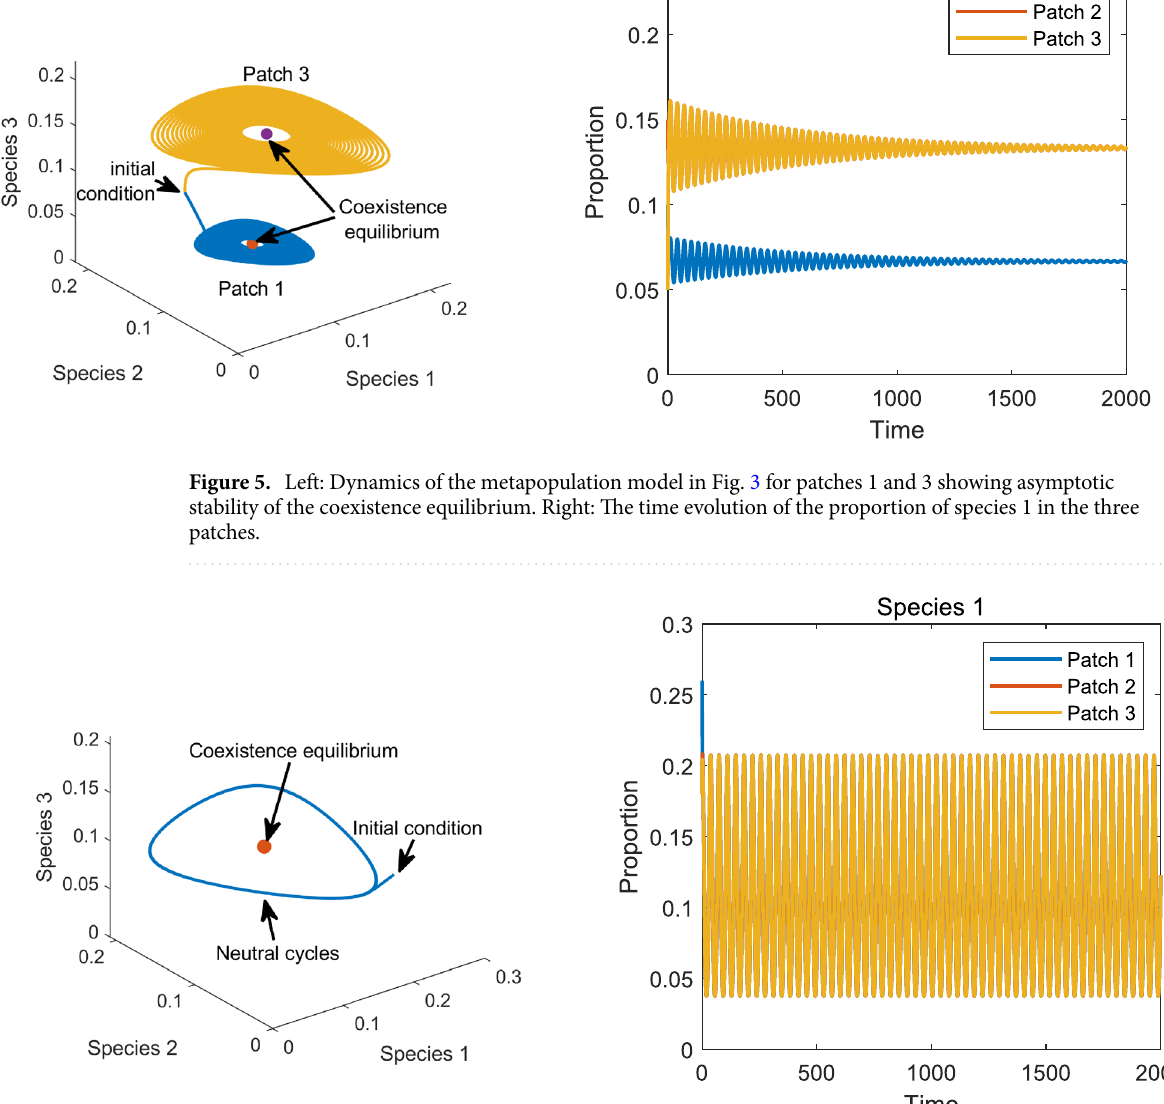
Figure 6. Left: Dynamics of the metapopulation model in Fig. 4 for patches 1 and 3 showing a limit cycle arising from the neutral stability of the coexistence equilibrium. Right: Time evolution of the proportion of species 1 in the three patches. Note that the dynamics in all patches are the same and thus the three graphs